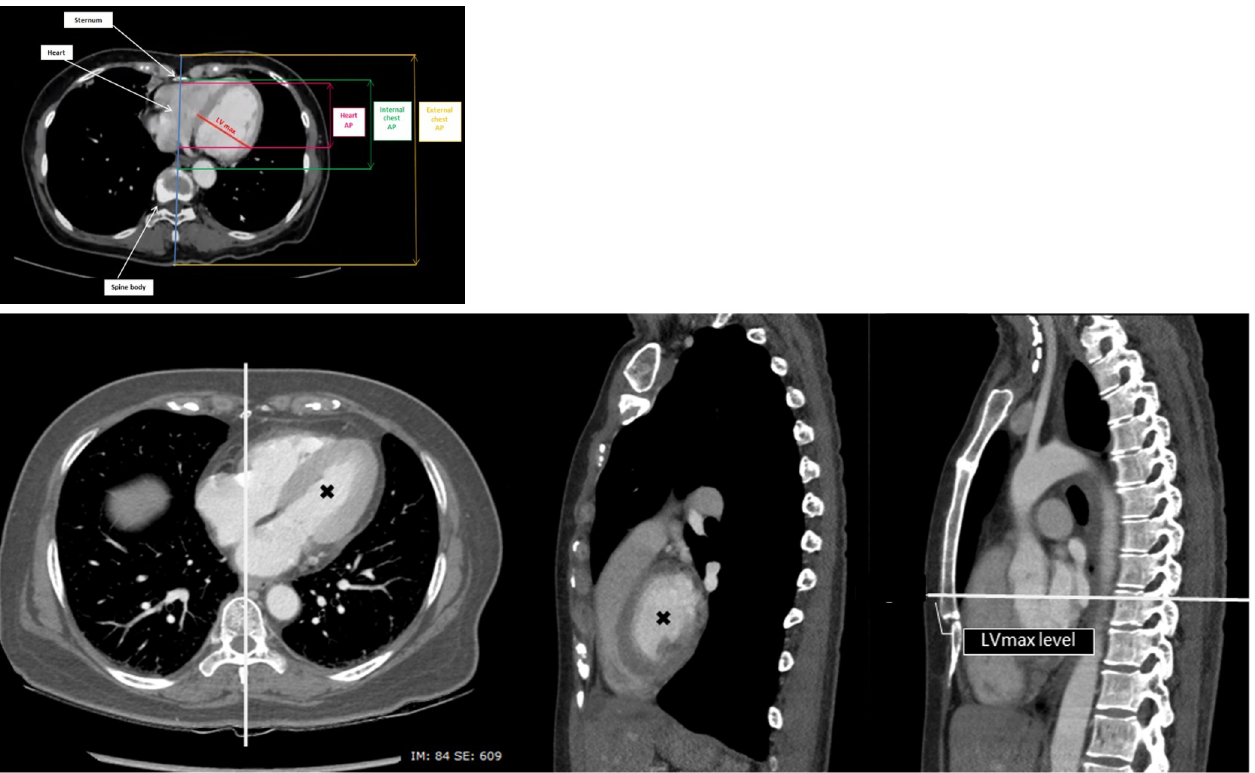
Fig 1. Axial chest CT image at the level of maximal left ventricular diameter (LV max). External chest anteroposterior diameter, internal chest anteroposterior diameter, and anteroposterior heart diameter were measured in the midline as shown. B , Midline sagittal chest CT image. The transverse white line represents the level of LV max demonstrated on the axial view, which corresponds to the mid-lower half of the sternum in this subject. (AP, anteroposterior. LV max, maximal left ventricular diameter on axial plane).